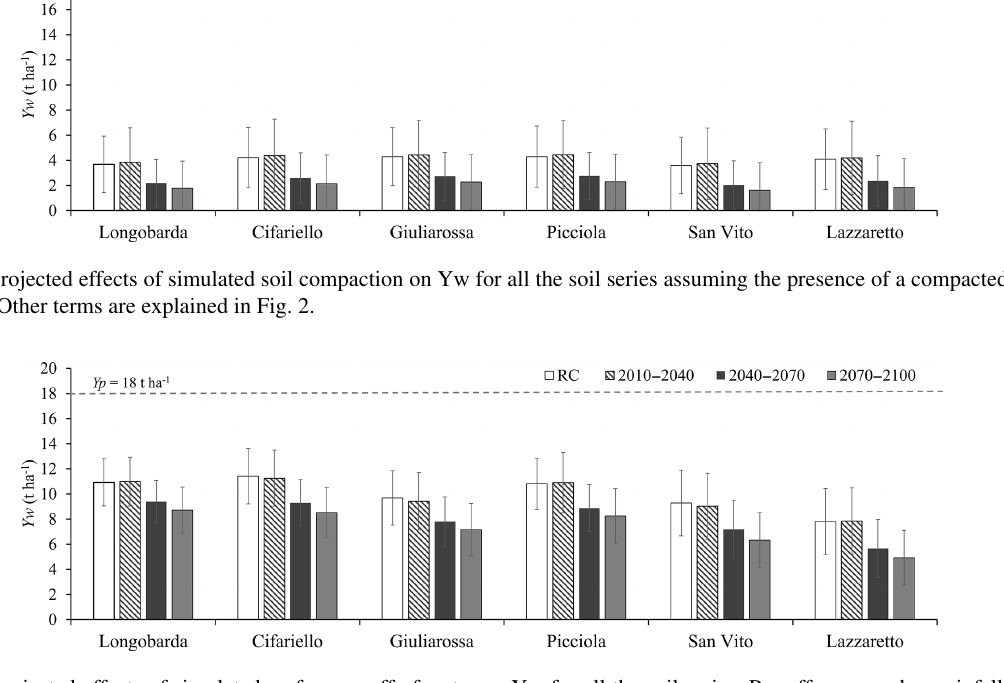
Figure 5. The projected effects of simulated surface runoff of water on Yw for all the soil series. Runoff occurs when rainfall intensity is higher than the assumed infiltrative capacity of the soil. Other terms are explained in Fig.